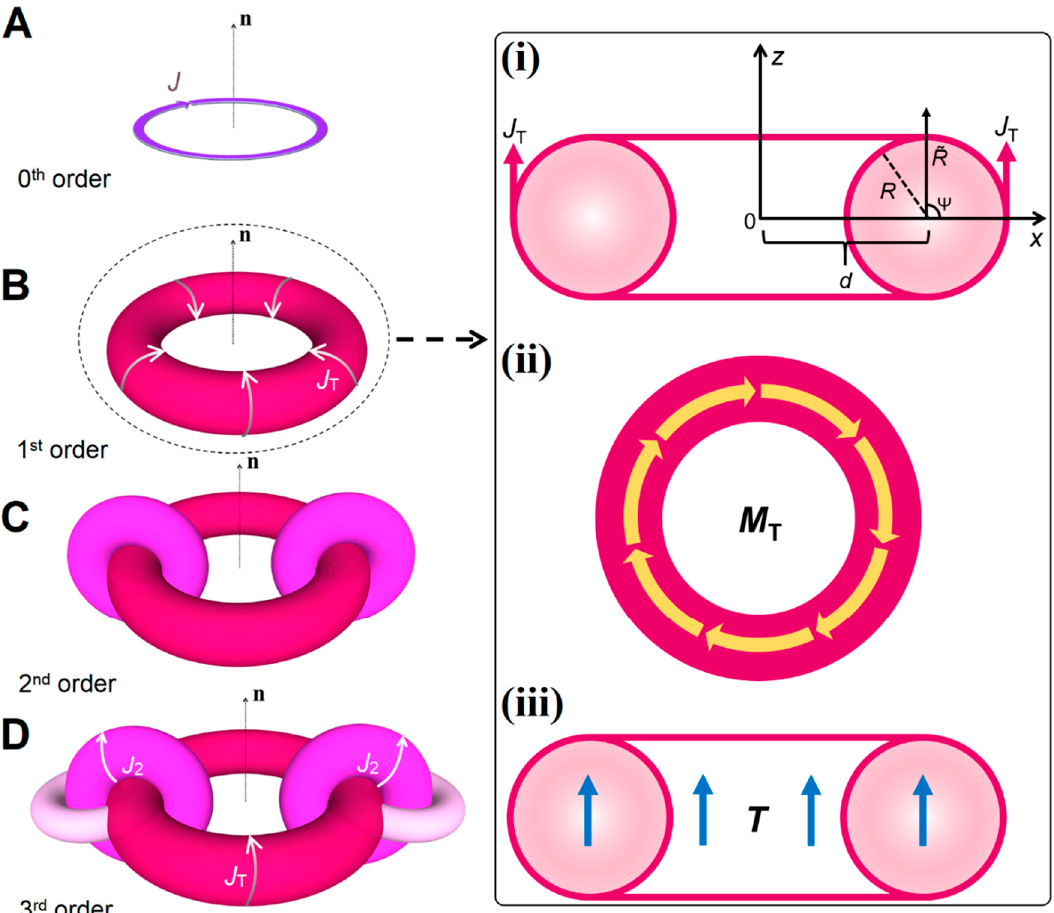
Figure 1. ( A ) Current distribution representation of a circular current-loop for a magnetic dipole. ( B ) Current-carrying, firmly winded (where the helicity of the solenoid vanishes) toroidal solenoid of 1st order. It can also be considered as a source of a toroidal dipole. The arrows demonstrate the poloidal currents flowing on the surface of an imaginary torus (i). Here, the torus is intensively wrapped by the magnetized rings (ii). The directed toroidization along the axis of the torus (iii). ( C ) Current-carrying, tightly winded toroidal solenoid of 2nd order (super-toroidal wire coil, pink-colored). The arrows indicate the related poloidal currents of the 2nd order toroidal solenoid, flowing on the surface of the pink-colored torus. ( D ) Current-carrying, closely winded toroidal solenoid of 3rd order (super-toroidal wire coil, pale pink-colored). The arrows indicate the corresponding poloidal currents of the 3rd order toroidal solenoid, flowing on the surface of the pale pink-colored torus.